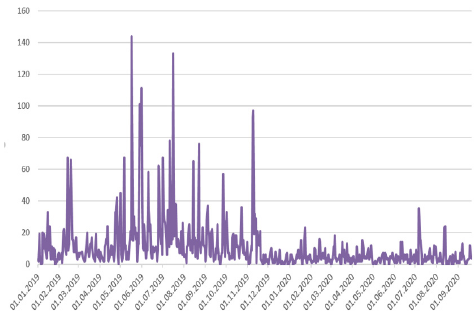
Figure 12. Dynamics of the neutral message base.